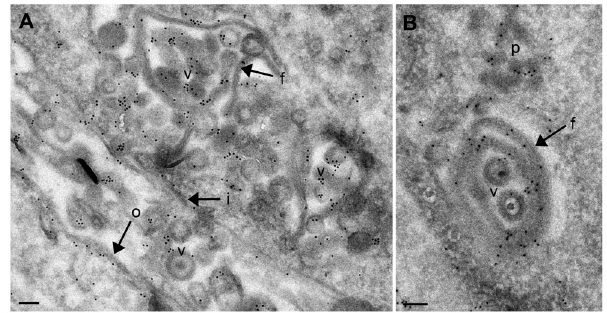
Figure 6. Transmission electron microscopy images of the nuclear periphery in Vero cells 20 hpi with CK177 Δ Us3gK-HA after immunogoldlabeling using antibodies against HA. ( A ) Shows an overview. ( B ) Shows a detail of membrane folds protruding into the nucleus. Gold particles are located on nuclear membrane folds (f), virions (v), nuclear membranes (i, o) and on protein deposits (p) in the nucleus. Bars, 200 nm.